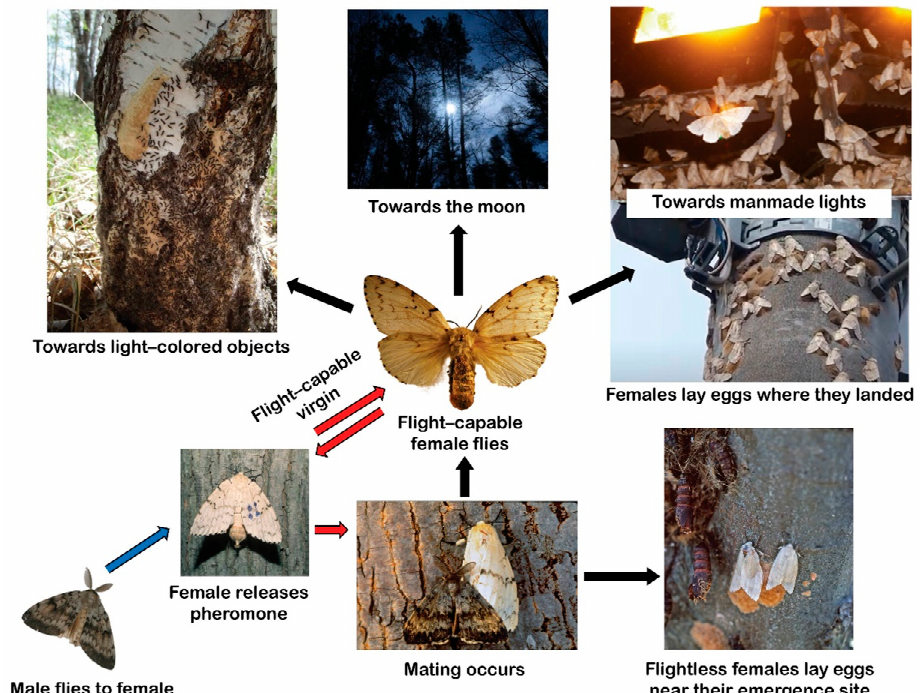
Figure 2. Schematic showing the sequence of mate finding, mating, female flight, and oviposition for populations with flight-capable or flightless females. Note that flight-capable virgin females will fly after calling for a few hours, when no mating occurs, but they will resume calling in the new location. Strong directed female flight to lights or light-colored objects occurs after mating, and females will congregate, in order to oviposit.